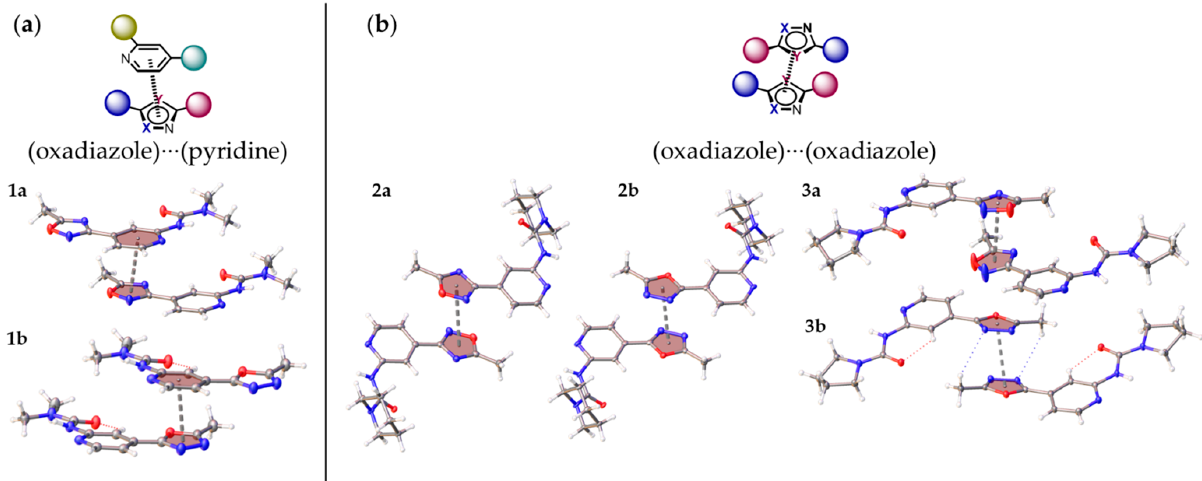
Figure 4. (Oxadiazole)···(pyridine) ( a ) or (oxadiazole)···(oxadiazole) ( b ) interactions in the XRD structure of ( 1 – 3 ) a , b . Table 1. Characteristic parameters of the π ··· π interactions in structures ( 1 – 3 ) a , b . Structure